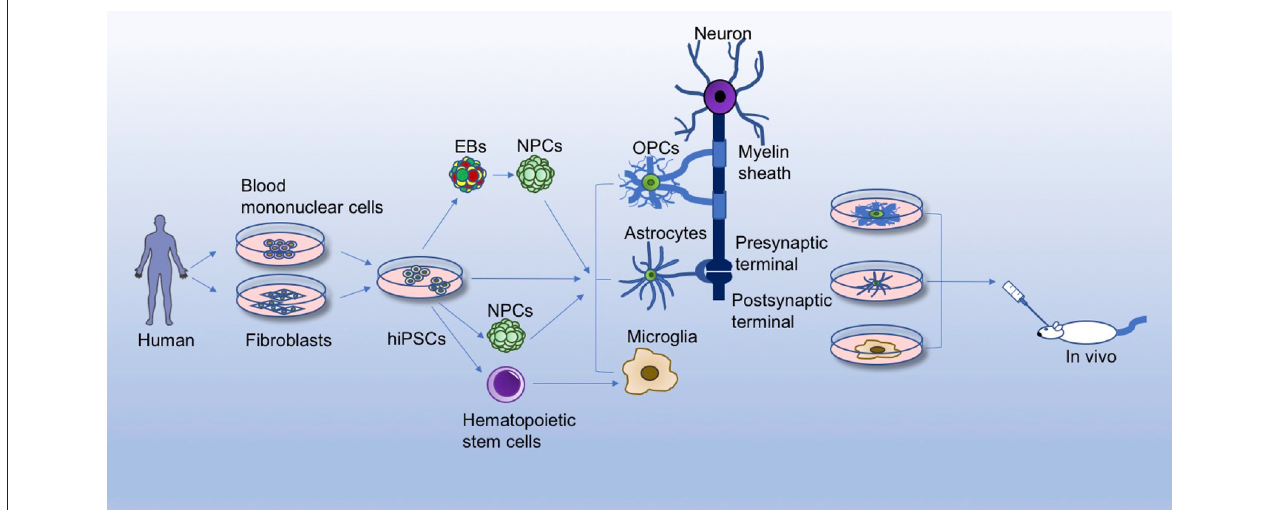
FIGURE 1 | Differentiation and application of hiPSC-derived glial cells . Human iPSCs (hiPSCs) reprogrammed from healthy person/patient-derived somatic cells can give rise to glial cells through different differentiation methods, for instance, by directly differentiating hiPSCs into glial cells, or by first inducing hiPSCs into embryoid bodies (EBs), neural progenitor cells (NPCs), or hematopoietic stem cells. hiPSC-derived glial cells offer a platform for studying the physiology of glia, disease mechanisms, and glia/neuron interactions in a culture dish. Accumulating evidence has revealed crucial roles of glial cells in the brain, such as rapid and saltatory conduction, motor skill learning, energy/trophic support, synapse formation, innate immune system function, etc. Meanwhile, hiPSC-derived glial cells can be transplanted into animal models (amytrophic lateral sclerosis, spinal cord injury, Alzhemier’s disease, multiple sclerosis, etc.) to evaluate the safety and efficacy for treatment of these